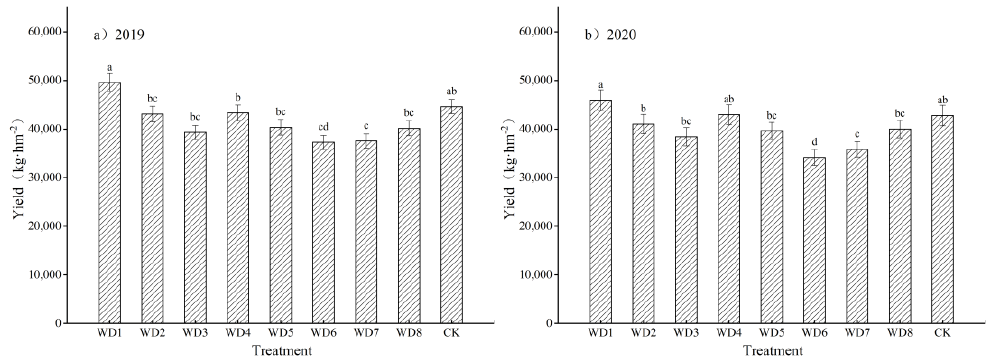
Figure 2. Potato production for the two growing seasons 2019 and